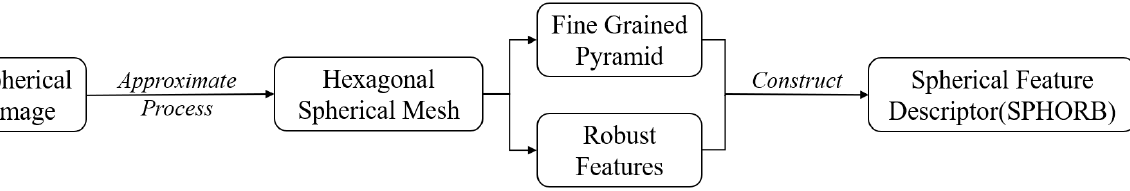
Figure 4. Spherical Oriented FAST and Rotated BRIEF (SPHORB) algorithm flow